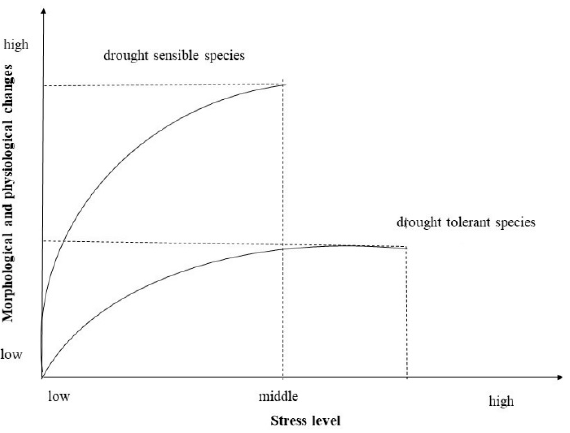
Figure 2. Graphic representation of morphological and physiological changes in drought-sensible and drought-tolerant ornamental plants as water stress level increases. Table 3. Water stress responsive genes.